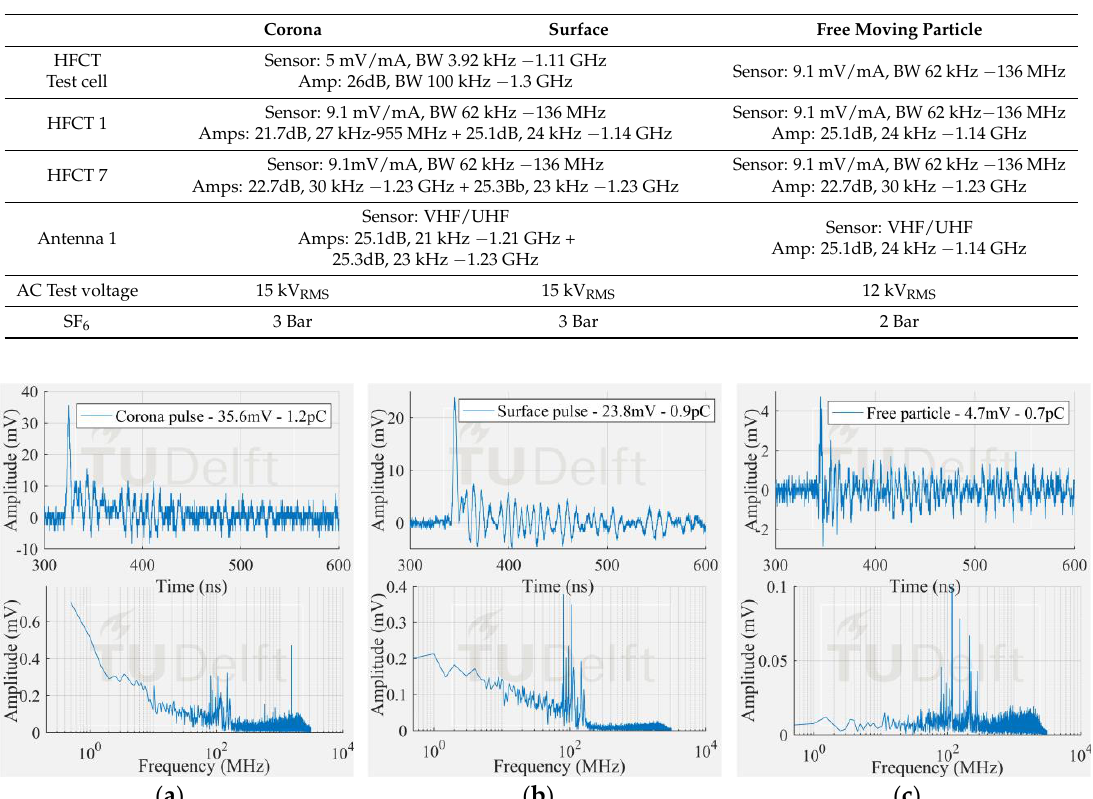
Table 1. Testing parameters used in each test cell.